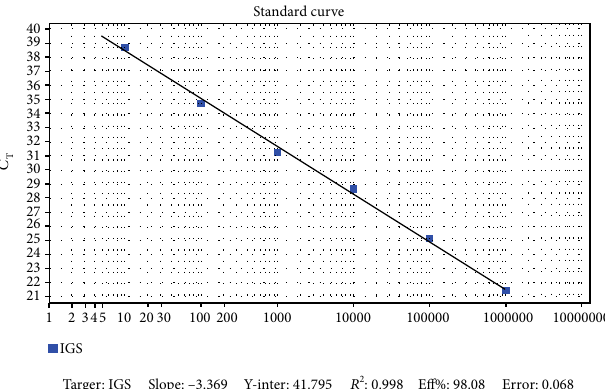
Figure 3: Reaction e ffi ciency with the Lb/IGS system shown in the standard curve. Standard curve resulting from the ampli fi cation reaction of Leishmania braziliensis (Lb) DNA in six points or concentrations, demonstrating a detection limit of up to 10fg for this specie. On the ordinate axis is the threshold cycle or cut-o ff point ( C ), and on the abscissa axis is the amount of template DNA in fentograms (fg). t IGS — Intergenic Spacer; rRNA — ribosomal